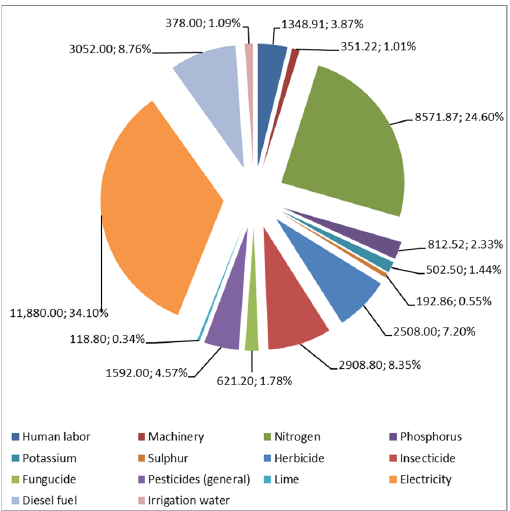
Figure 2. Distribution of energy inputs in the production of oranges.